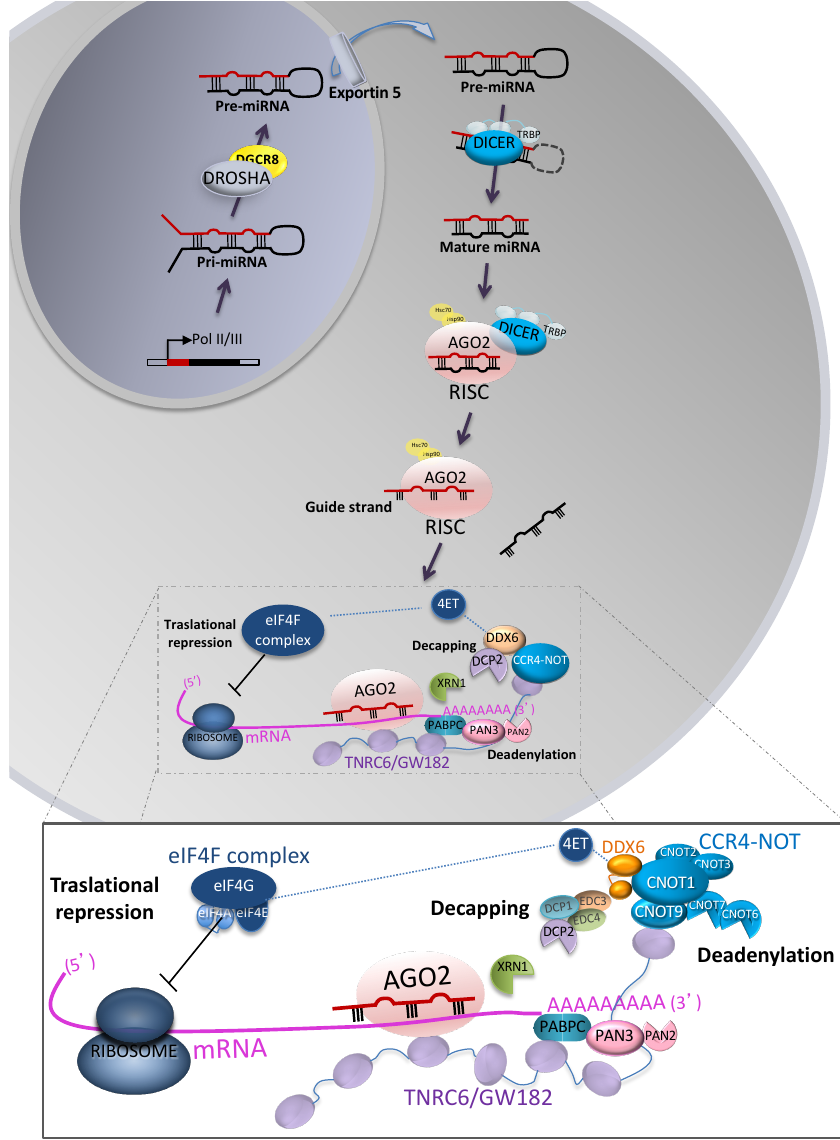
Figure 1. Canonical biogenesis and post-transcriptional gene silencing of microRNAs (miRNAs). In the nucleus, the miRNA gene is transcribed by RNA polymerase as a primary transcript (pri-miRNA), which is further processed by the Drosha complex to produce the precursor miRNA (pre-miRNA). Pre-miRNA is exported to the cytoplasm by exportin-5, where it is cleaved by the Dicer / TRBP complex to produce the double-stranded mature miRNA. Mature miRNA is loaded into argonaute 2 (AGO2) with the assistance of Dicer / TRBP and other proteins that form the RNA-induced silencing complex (RISC). On RISC, one miRNA strand is retained (guide strand) and the other is expulsed. miRNA binds to its target mRNA by base pairing to a partially complementary binding domain and induces gene silencing by mRNA decay and translational repression. mRNA decay involves the deadenylation and decapping of the target mRNA, followed by degradation by exoribonuclease XRN1. Deadenylation is catalyzed by PABPC and the deadenylase complexes PAN2–PAN3 and CCR4–NOT, whereas decapping is carried out by the decapping protein 2 (DCP2) with the assistance of factors DCP1, EDC3, EDC4, and DDX6. Translational repression occurs when the DDX6 interacts with 4E-transporter (4E-T), which is required for the assembly of the eukaryotic initiation factor 4F (eIF4F) complex. TRBP: transactivation response RNA binding protein; PABPC: cytoplasmic poly(A)-binding protein; EDC3 and EDC4: enhancer of decapping 3 and 4; DDX6: DEAD box protein